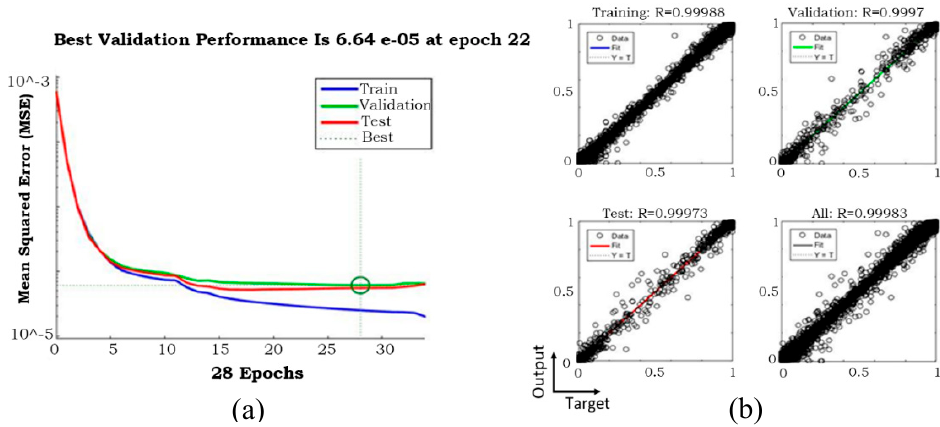
Figure 10. NN ( a ) validation performance and ( b ) regression when temporal time-step was 0.002 s.